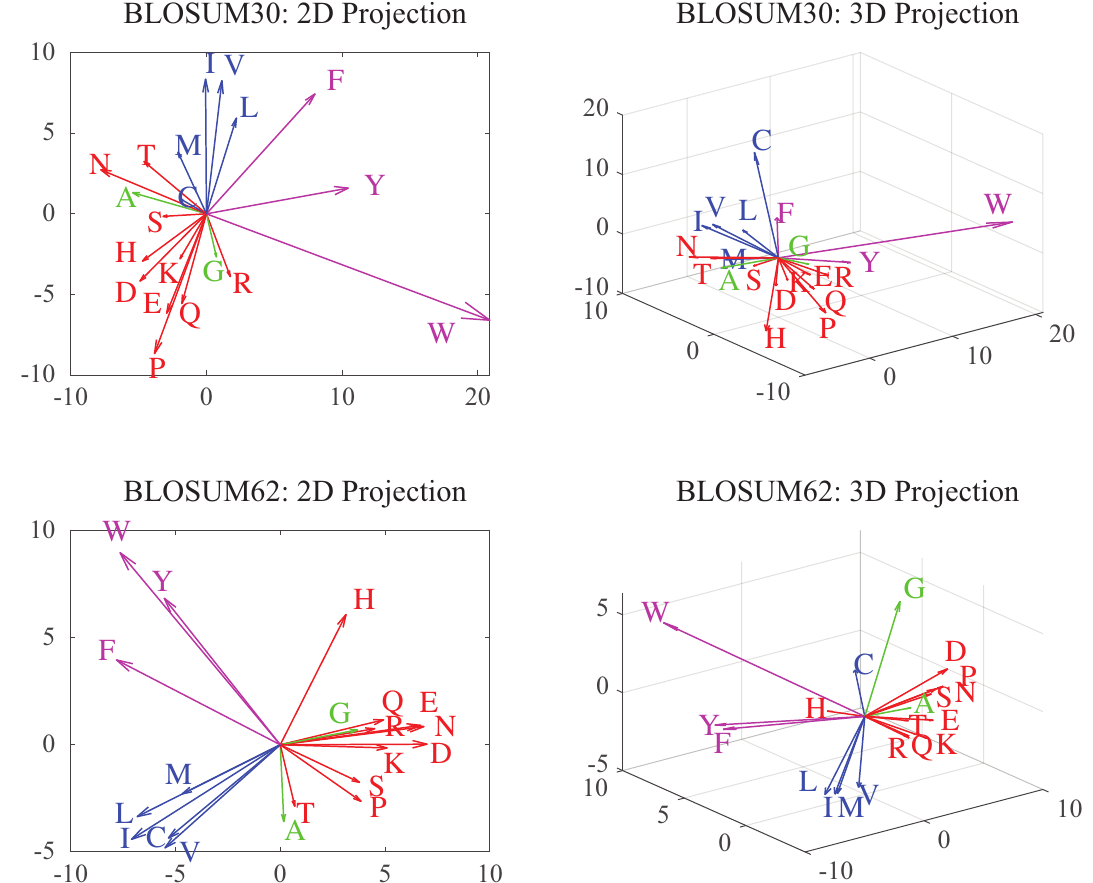
Figure 5. These plots represent the 2D (left panels) and 3D (right panels) vector representations of amino acids as derived from the BLOSUM30 ( top ), and BLOSUM62 ( bottom ) matrices. The proximity of these vectors relate to the chemical similarities of the amino acids they represent. To highlight this fact, we show the known polar amino acids (Q, R, E, K, H, N, D, T, P, and S) in red, the hydrophobic amino acids (M, V, L, I and C) in blue, and the aromatic amino acids (Y, F, and W) in magenta. Note that the two small amino acids, A and G (in green), stand